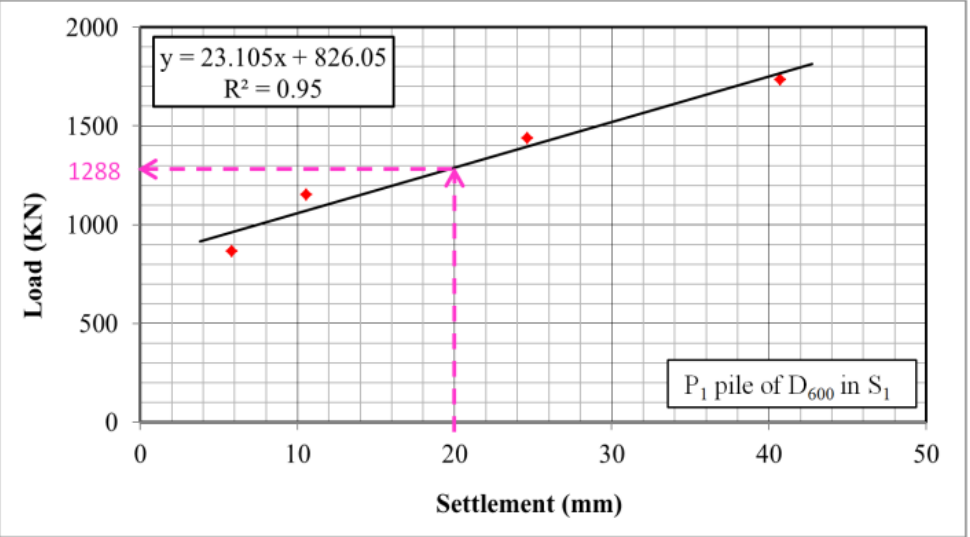
Fig. 3. Single pile of diameter 600mm in soil S